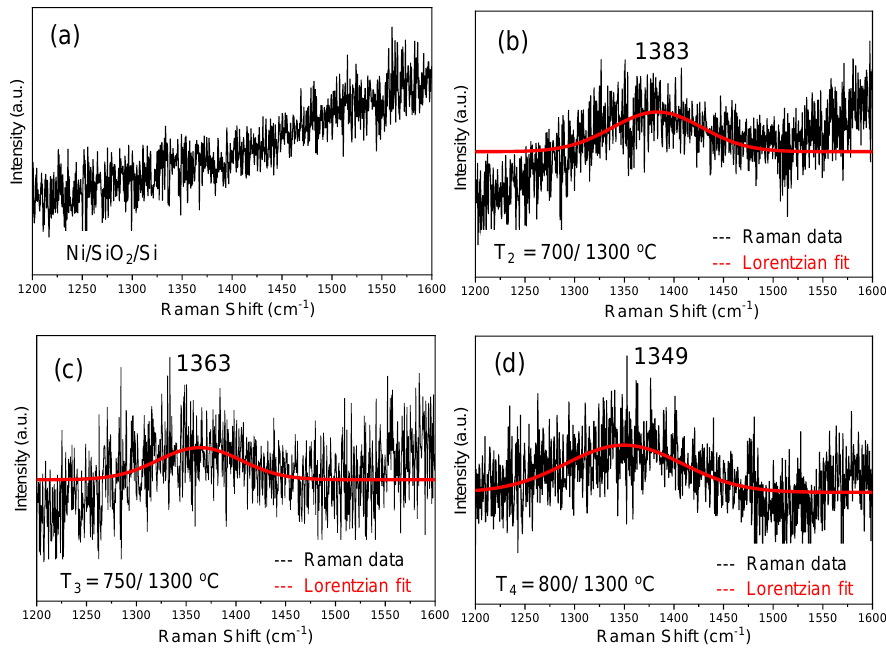
Figure 5. Raman spectra: ( a ) Ni/SiO2/Si substrate, ( b ) T 2 , ( c ) T 3 , and ( d ) T 4 samples.